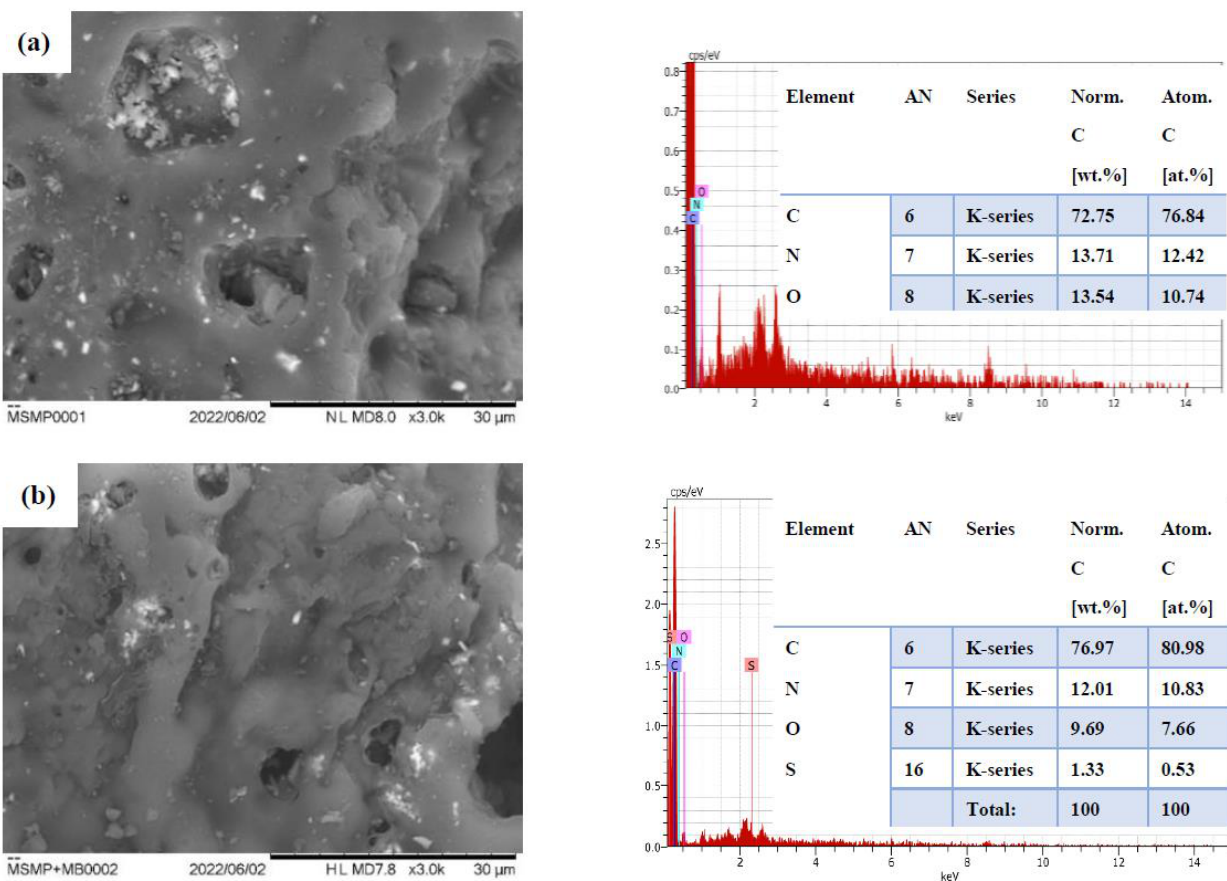
Figure 4. SEM images and EDX spectra of ( a ) MSMPAC and ( b ) MSMPAC-MB at a magnification of 3.0k.